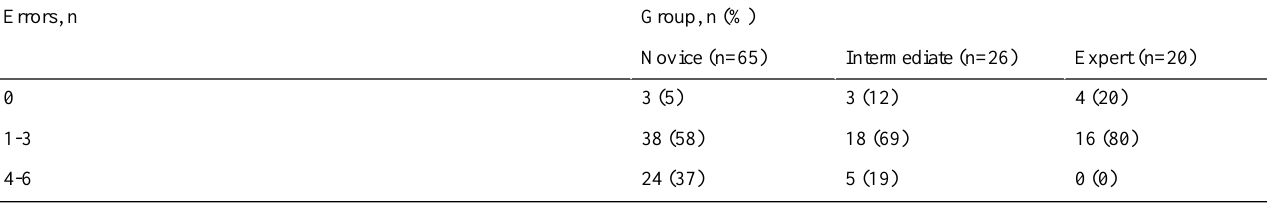
Table 2. Numbers of participants who made 0, 1-3, and 4-6 errors in each